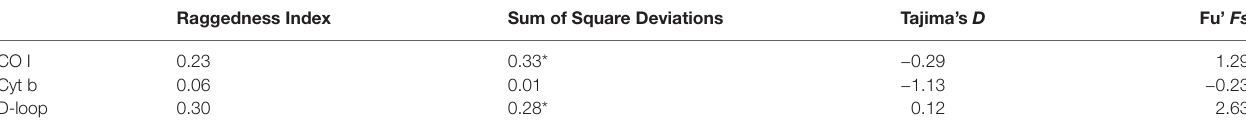
TABLE 3 | Goodness of fit and neutrality tests for partial sequences of the mtDNA CO I, Cyt b, and D-loop markers in the wild population of Procypris